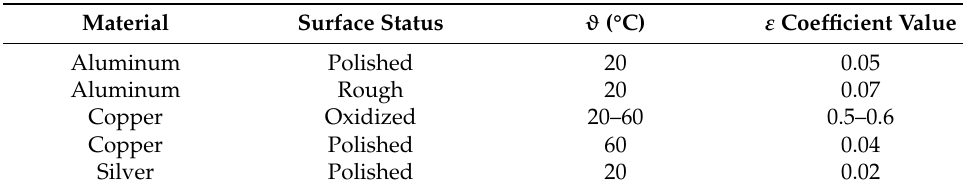
Table 1. ε coefficient values for various